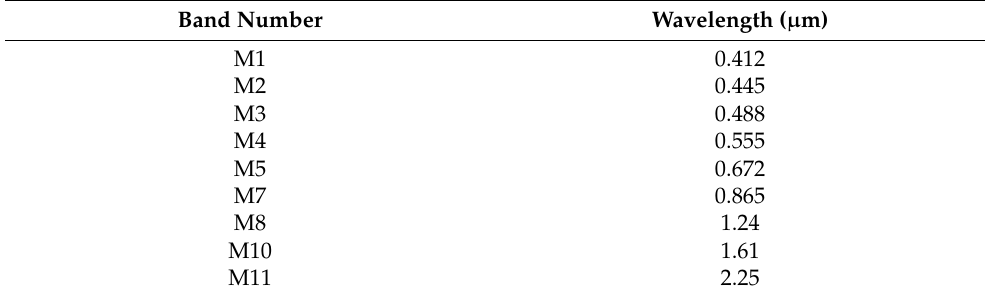
Table 1. Visible Infrared Imaging Radiometer Suite (VIIRS) bands used to map canopy structure. Band Number Wavelength ( µ